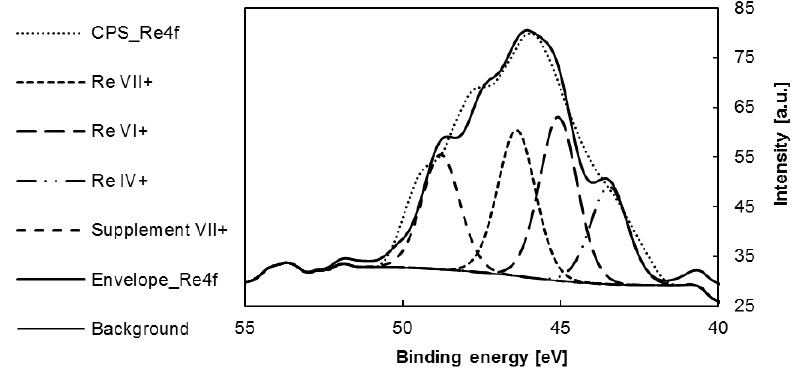
Figure 7. X-ray photoelectron spectroscopy (XPS) spectrum with fitted peaks of MTO/ZnCl /MA5 (after 3h in 2